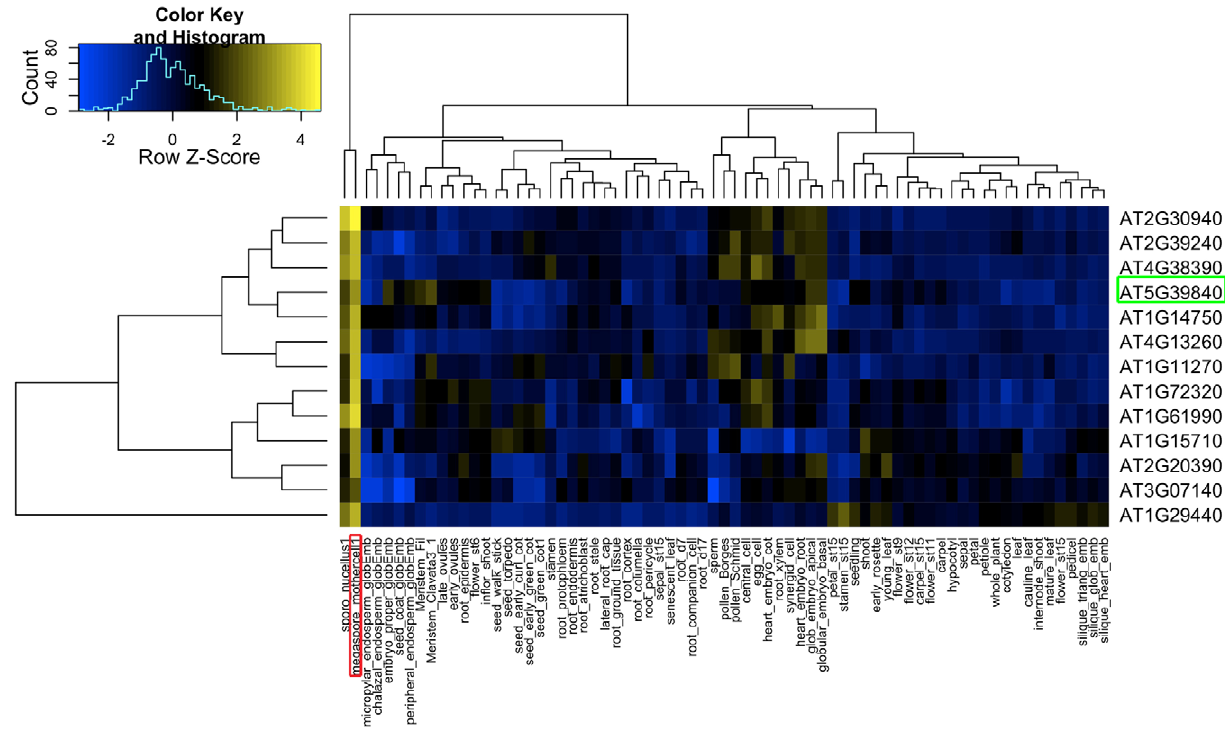
Figure 4. Heatmap of expression values for genes enriched in MMCs as compared to the tissue atlas. Heatmap of log2-transformed mean expression values showing 13 genes significantly enriched in the MMC samples as compared to the tissue atlas composed of a total of 72 from different Arabidopsis cell types and tissues ( p value , 0.01 after Benjamini-Hochberg adjustment). Hierarchical clustering of genes/samples was based on euclidean distance and hierarchical agglomerative clustering. Colors are scaled per row and yellow denotes high expression and blue low expression. Red box, MMC; green box, MEM . doi:10.1371/journal.pbio.1001155.g004 PLoS Biology |